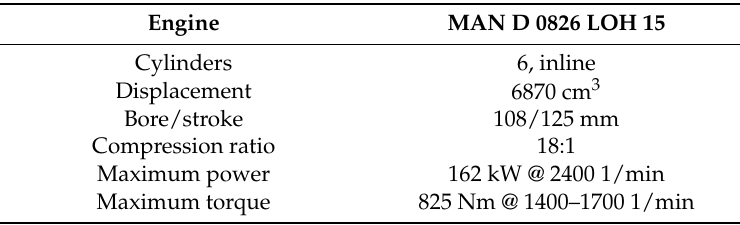
Table 4. MAN engine